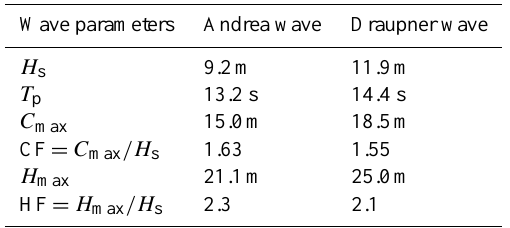
Table 1. Characteristics of the Andrea and New Year